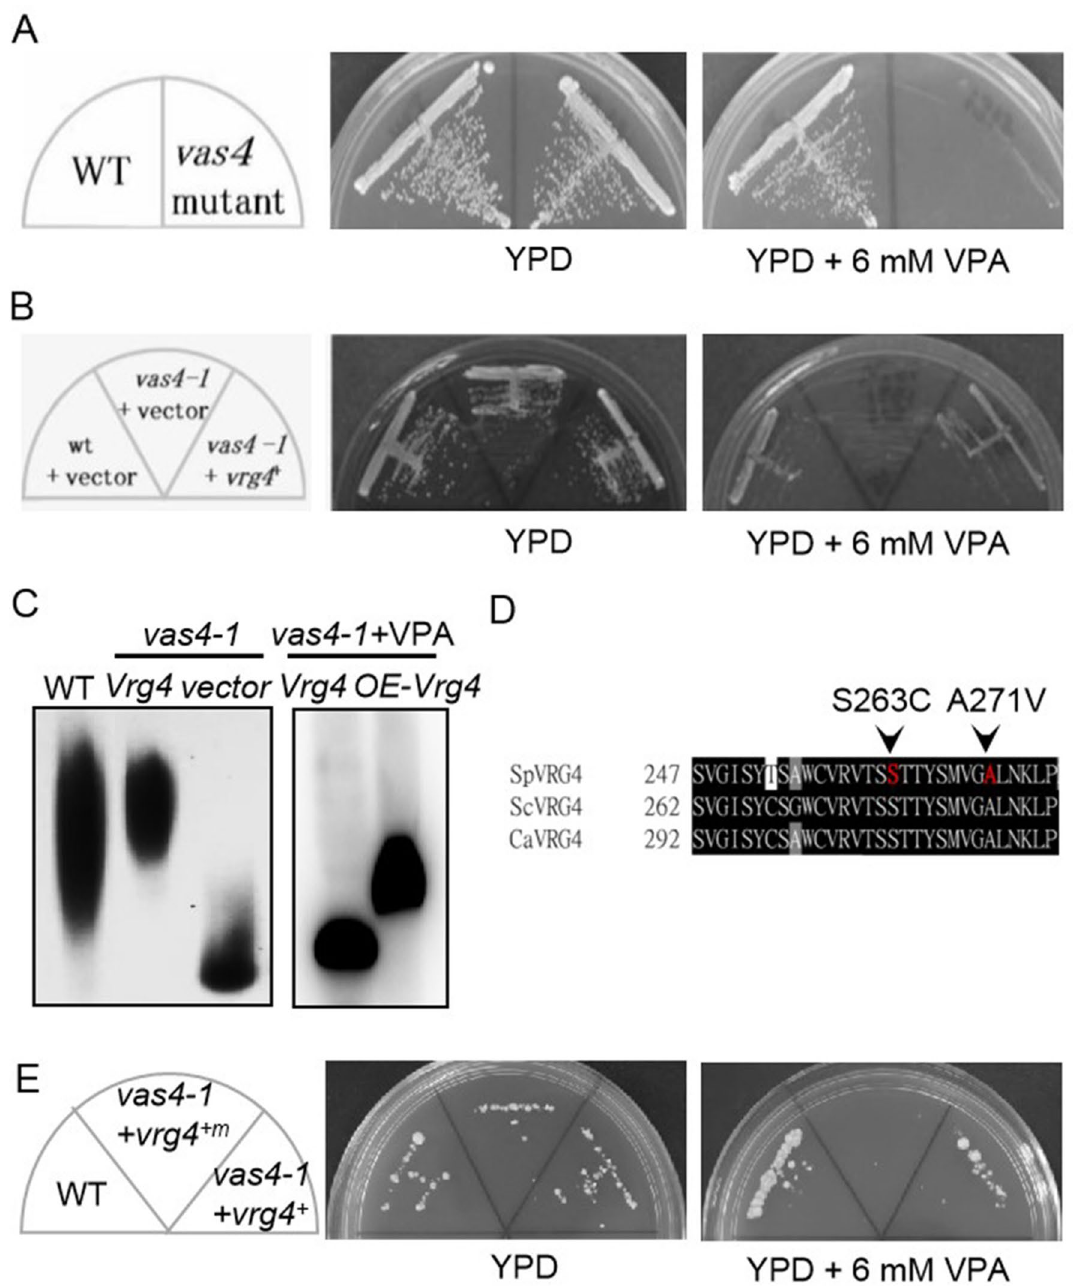
Figure 1. Mutation in the vas4 + / vrg4 + gene leads to a VPA-sensitive phenotype. ( A ) vas4-1 was identified as a VPA-sensitive mutant. WT and vas4-1 were streaked on plates containing YPD or YPD plus 6 mM VPA and then incubated for 4 days at 27 °C. ( B ) The vas4 + / vrg4 + gene can complement the VPA-sensitive phenotype of vas4-1 . Cells transformed with control or a vector containing the vas4 + / vrg4 + gene were streaked on plates containing YPD or YPD plus 6 mM VPA and then incubated for 4 days at 27 °C. ( C ) Acid phosphatase staining of cells with WT, vas4-1 + Vector, vas4-1 + Vrg4 + , vas4-1 + Vrg4 + + 6 mM VPA or vas4- 1 + overexpressed (OE) - Vrg4 + + 6 mM VPA. ( D ) Partial protein sequence alignment of ScVrg4p, SpVrg4p and CaVrg4p. ( E ) S263C and A271V in SpVrg4p are the key contributors to VAP sensitivity. WT and vas4-1 cells transformed with the control or a vector containing the vas4 + / vrg4 + gene were streaked on plates containing YPD or YPD plus 6 mM VPA and then incubated for 4 days at 27